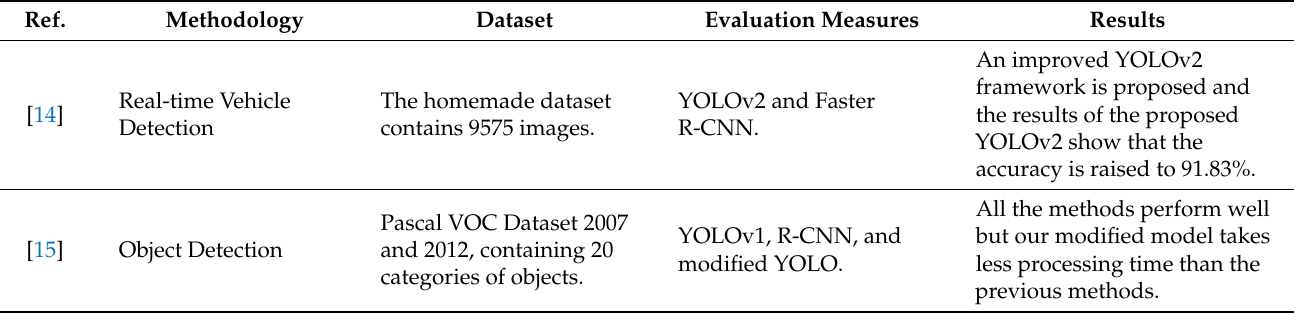
Table 1. Summary of existing techniques for vehicle